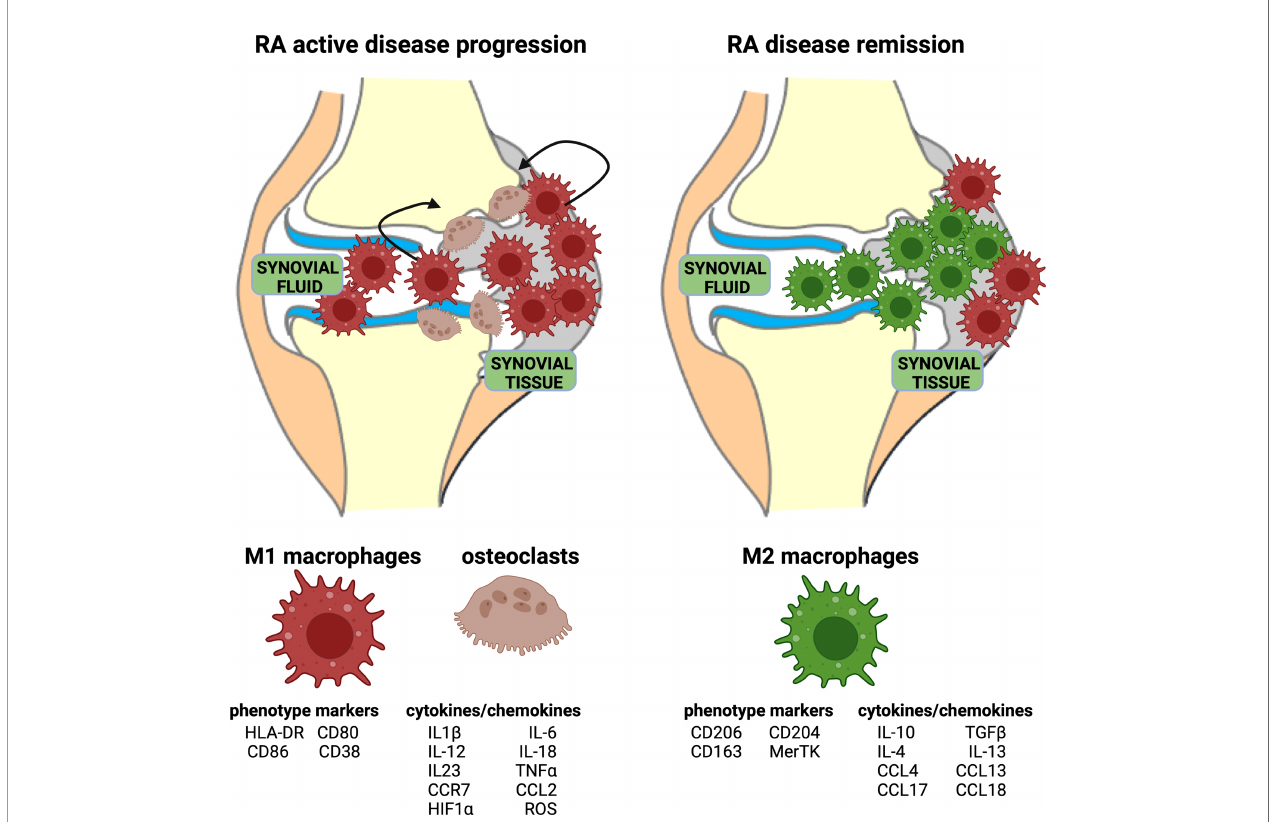
FIGURE 2 | Representation of acute RA in fl ammation and remission. Acute RA in fl ammatory phase is characterized by an imbalance in M1 – M2 ratio in synovial fl uid and tissue. This phase is dominated by a higher percentage of pro-in fl ammatory M1 macrophages, which display speci fi c phenotype markers and release cytokines/ chemokines. Moreover, the activation of osteoclasts contributes to bone erosion. RA disease remission is characterized by a high percentage of anti-in fl ammatory M2 macrophages, which display speci fi c phenotype markers and release anti-in fl ammatory